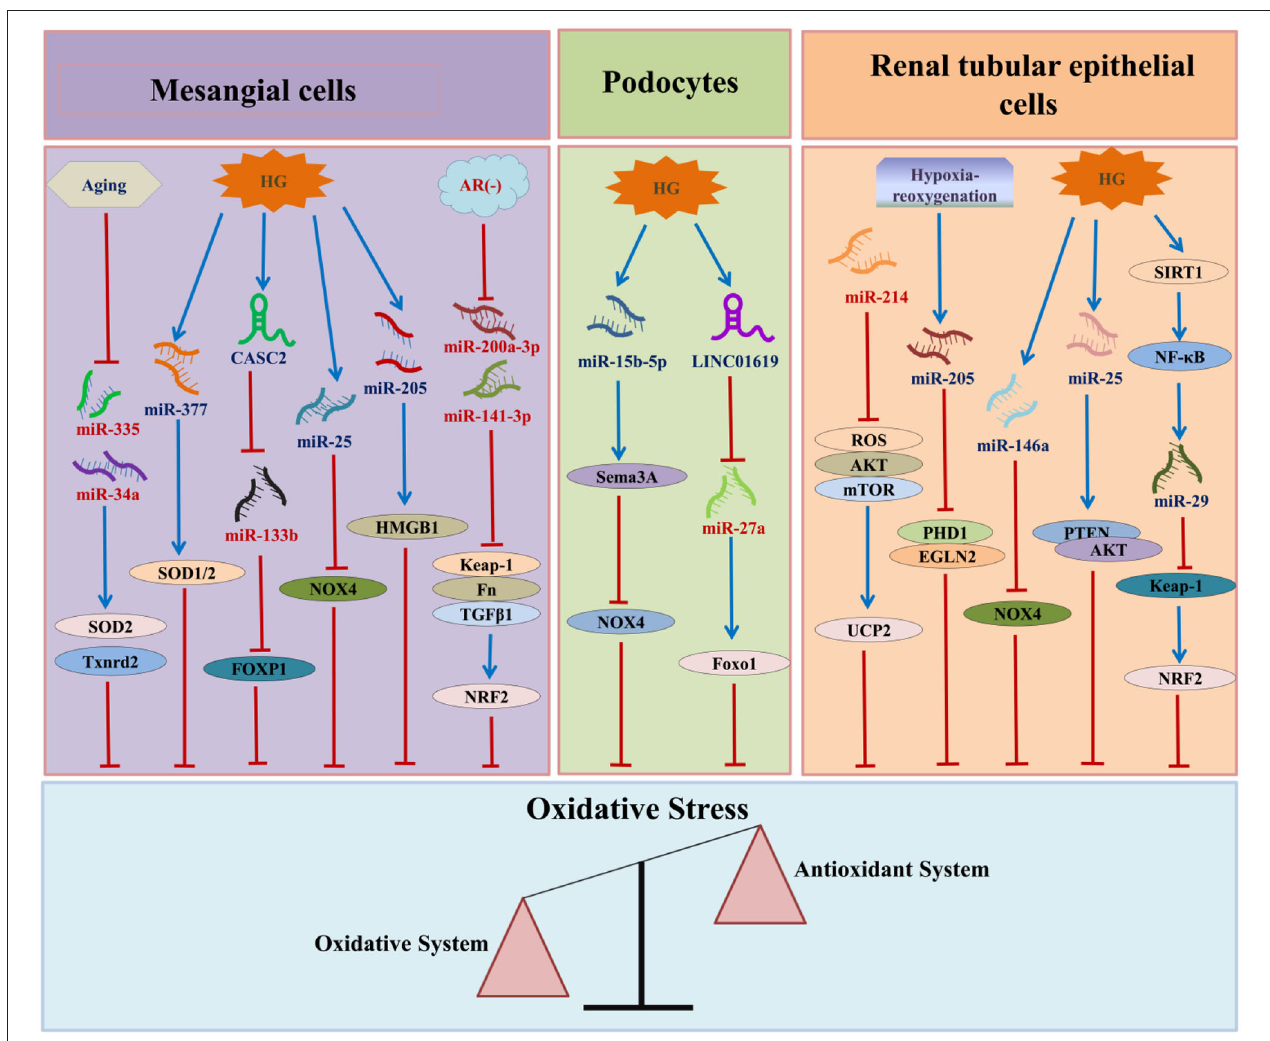
FIGURE 3 | The relationship between ncRNAs and DN-associated oxidative stress. HG, high glucose; AR, aldose reductase; CASC2, cancer susceptibility candidate 2; HMGB1, high mobility group box 1; SOD, superoxide dismutase; NOX4, nicotinamide adenine dinucleotide phosphate oxidase 4; FN, fibronectin; TGF- β 1:transforming growth factor β 1:TXNRD2, thioredoxin reductase 2; FOXP1, forkhead box P1; NRF2, nuclear factor erythroid E2-related factor 2; SEMA3A, semaphorin 3A; Foxo1, Forkhead box 1; ROS, reactive oxygen species; AKT, protein kinase B; mTOR, mechanistic target of rapamycin; UCP2, uncoupling protein 2; SIRT1, Sirtuin 1; NF- κ B, nuclear factor-kappa B; PTEN, phosphatase and tensin homolog; PHD1, prolyl hydroxylase